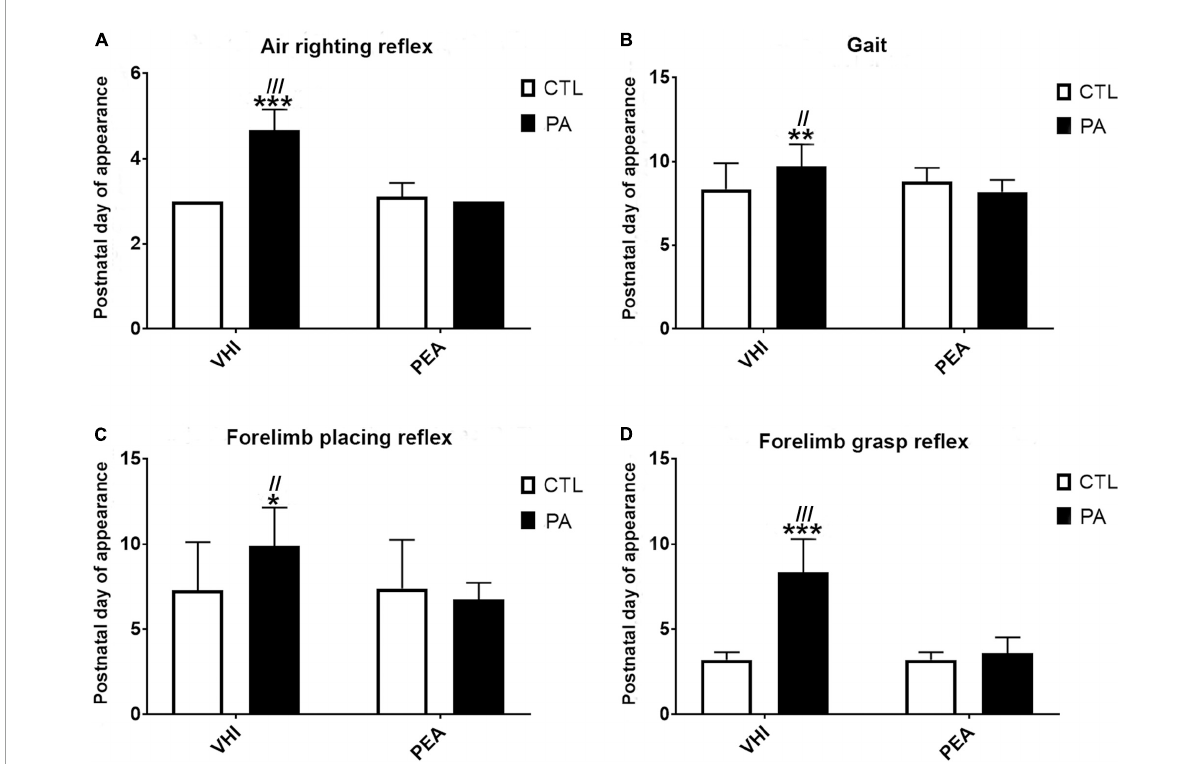
FIGURE2 Neurobehavioral development. (A) Air-righting reflex. (B) Gait. (C) Forelimb placing reflex. (D) Forelimb grasp reflex. Results are expressed as mean ± SEM. * p < 0.05, PA-VHI vs. CTL-VHI; ** p < 0.01, PA-VHI vs. CTL-VHI; *** p < 0.001, PA-VHI vs. CTL-VHI; // p < 0.01, PA-VHI vs. PA + PEA; ///